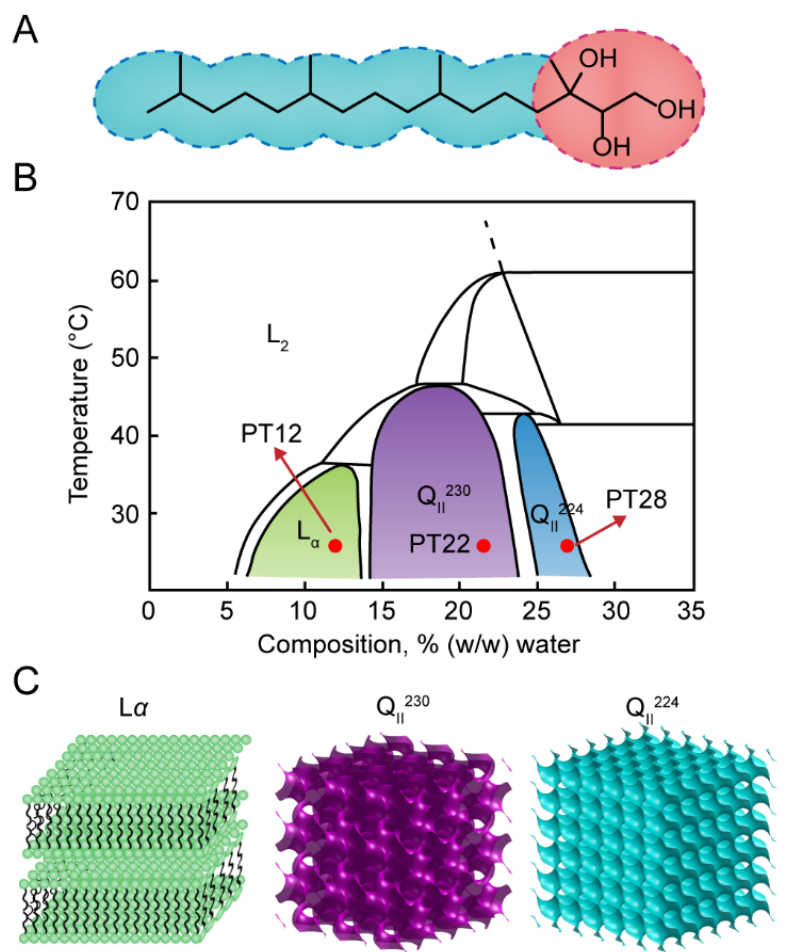
Figure 1. The introduction of phytantriol-based LLCs. ( A ) The structure of phytantriol molecule. ( B ) The phase diagram of the phytantriol/water system. ( C ) 3D structure of L α , Q II230 and Q II224